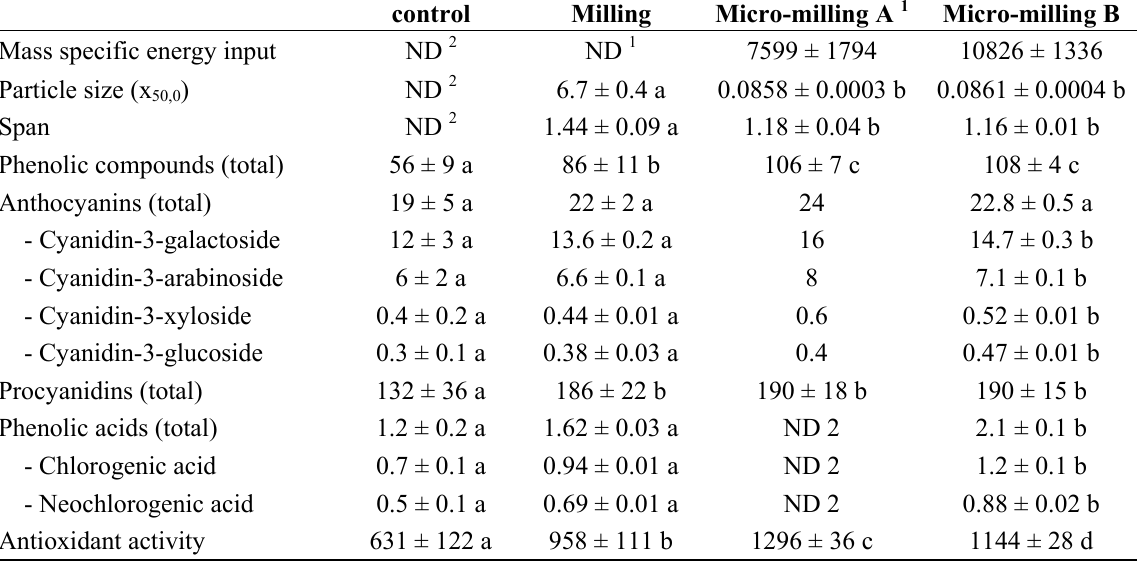
Table 2. Mass specific energy input, particle sizes (µm), spans, total phenolic compounds ) and antioxidant activity (mmol/kg ) of untreated, milled and contents (g/kg dm dm micro-milled (protocols A, B) chokeberry pomace (mean values; standard deviation; n ≥ 2; means with different letters (a, b, c, d) within the same row are significantly different; P ≤